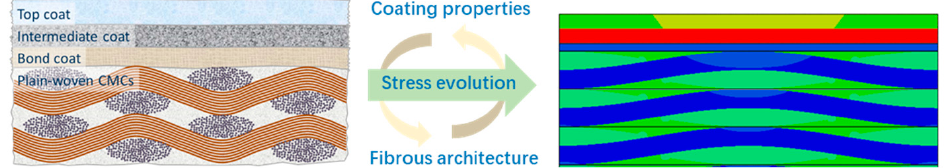
Figure 8. The failure model of a CMC/EBC system considering the synergetic effects of the coating properties and fibrous architecture.